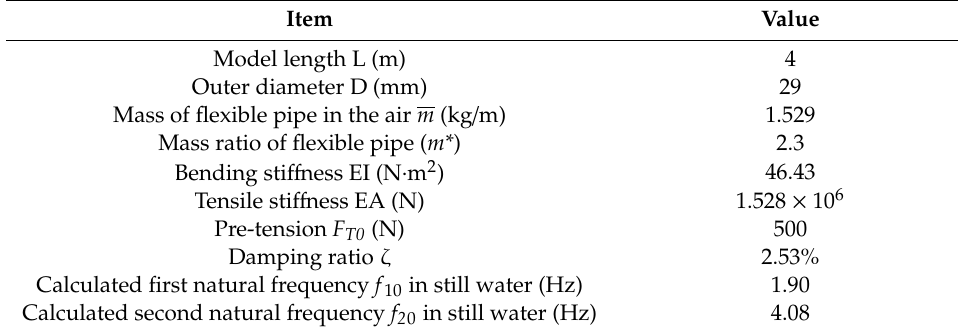
Table 2. Parameters of the flexible pipe model.